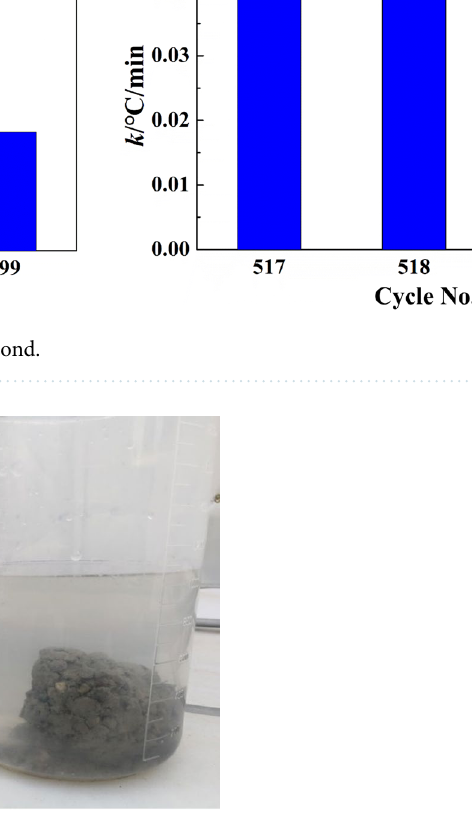
Figure 18. Mud cake sample was taken out form